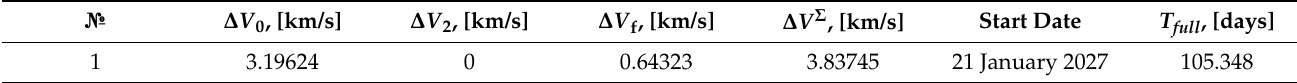
Table 1. The optimal solution of the auxiliary problem (25).